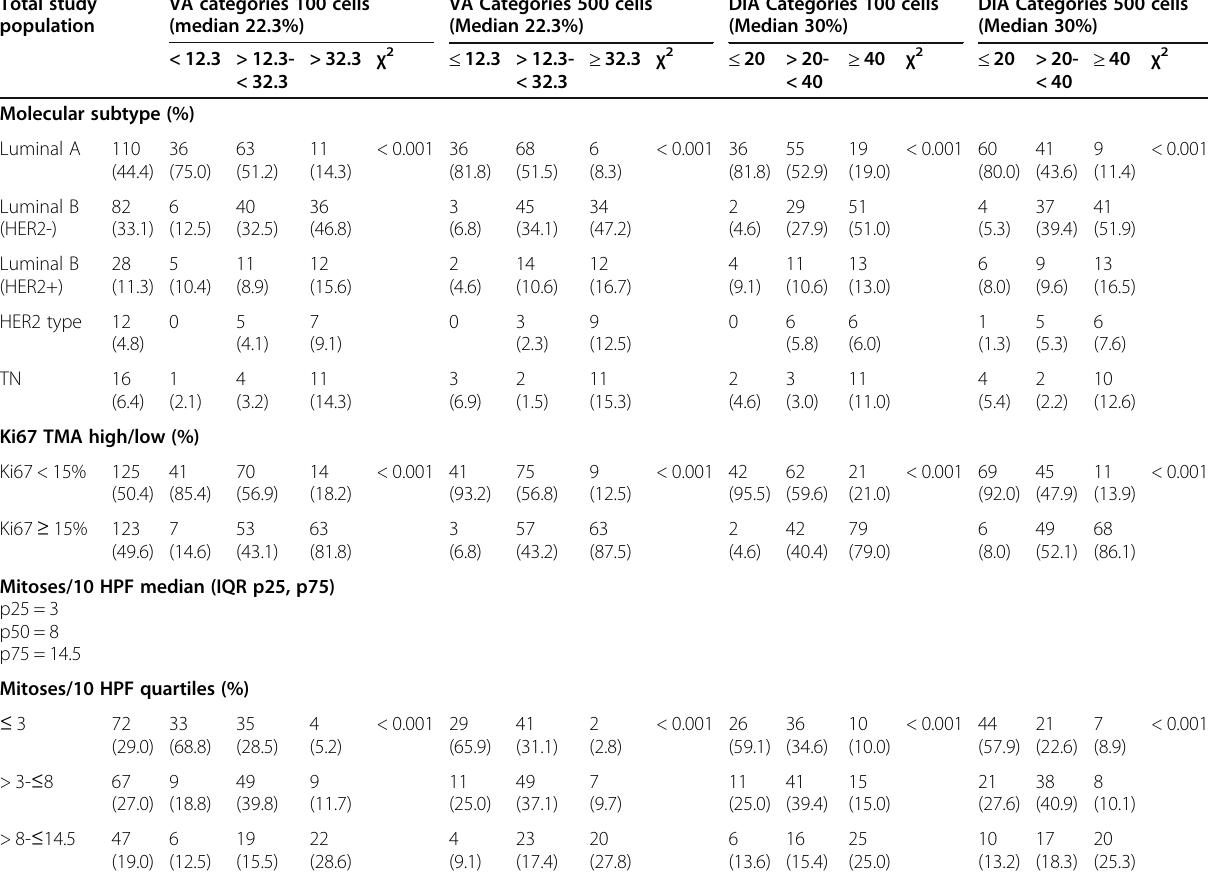
Table 1 Patient and tumour characteristics according to Ki67 visual assessment (VA) and digital image analysis (DIA) of full face tissue sections (Continued)